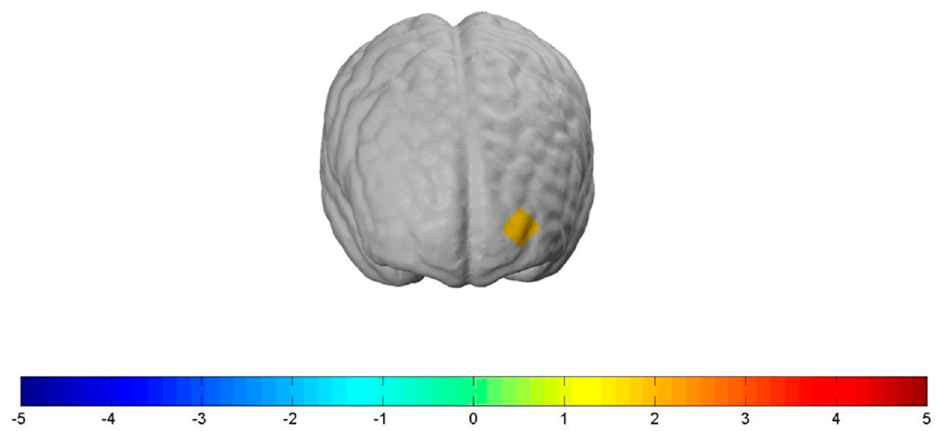
Figure 5. Significantly increased neural prefrontal cortex activation for the contrast between the “Stop” condition versus the “Neutral” condition: channel 22: t(78) = 1.93, p ≤ 0.1, d = 0.437; channel 21: t(78) = 1.69, p ≤ 0.1, d = 0.382; channel 19: t(78) = 1.97, p ≤ 0.1, d = 0.315, and channel 17: t(78) = 1.71, p ≤ 0.1, d = 0.446. The activation threshold was set to p < 0.1.